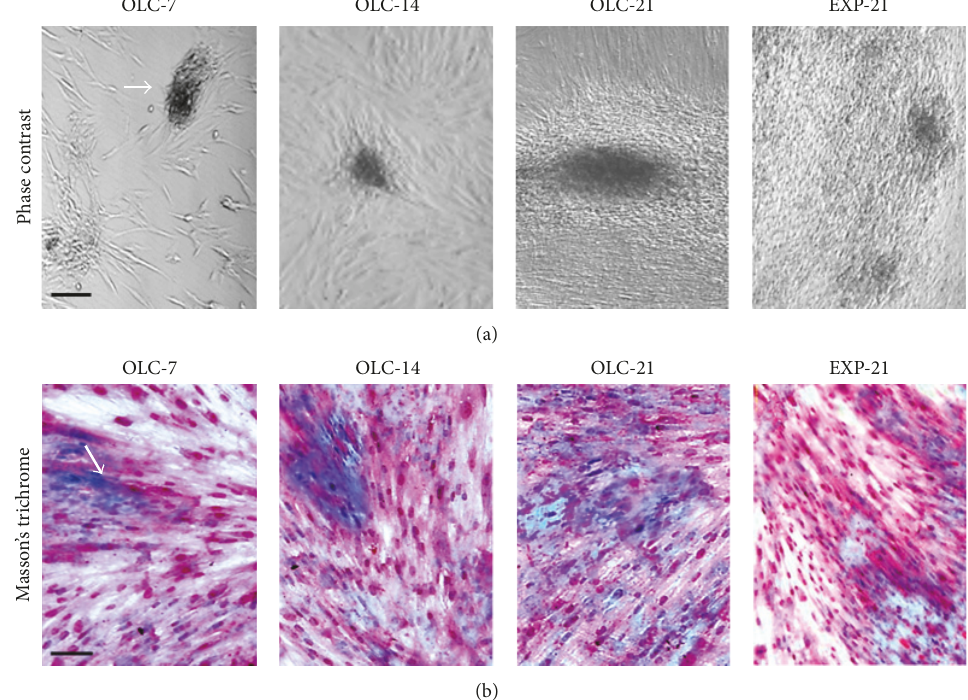
Figure 7: Extracellular matrix deposition . OLC and EXP-21 cultures were exposed to differentiation-inductive conditions. Cell aggregates (black arrow) became the centers where there was an extensive deposition of extracellular matrix components. Masson’s trichrome staining (black arrow, (b)) shows the deposition of COL-I. Scale bar: 100 𝜇